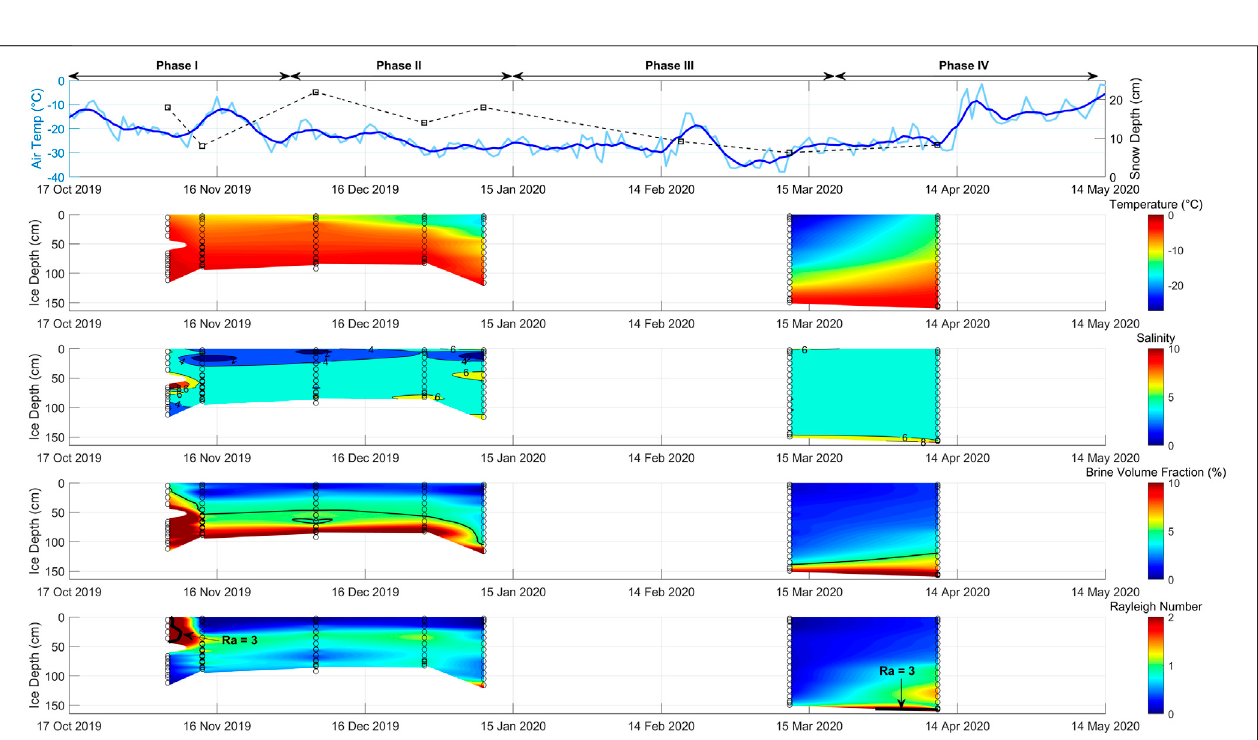
FIGURE 5 | The evolution of physical properties at the BGC3 site. See Figure 3 caption for a description of common labels and annotations. In early November, a seawater pocket was encountered where the ice column consisted of two FYI layers affected by rafting.